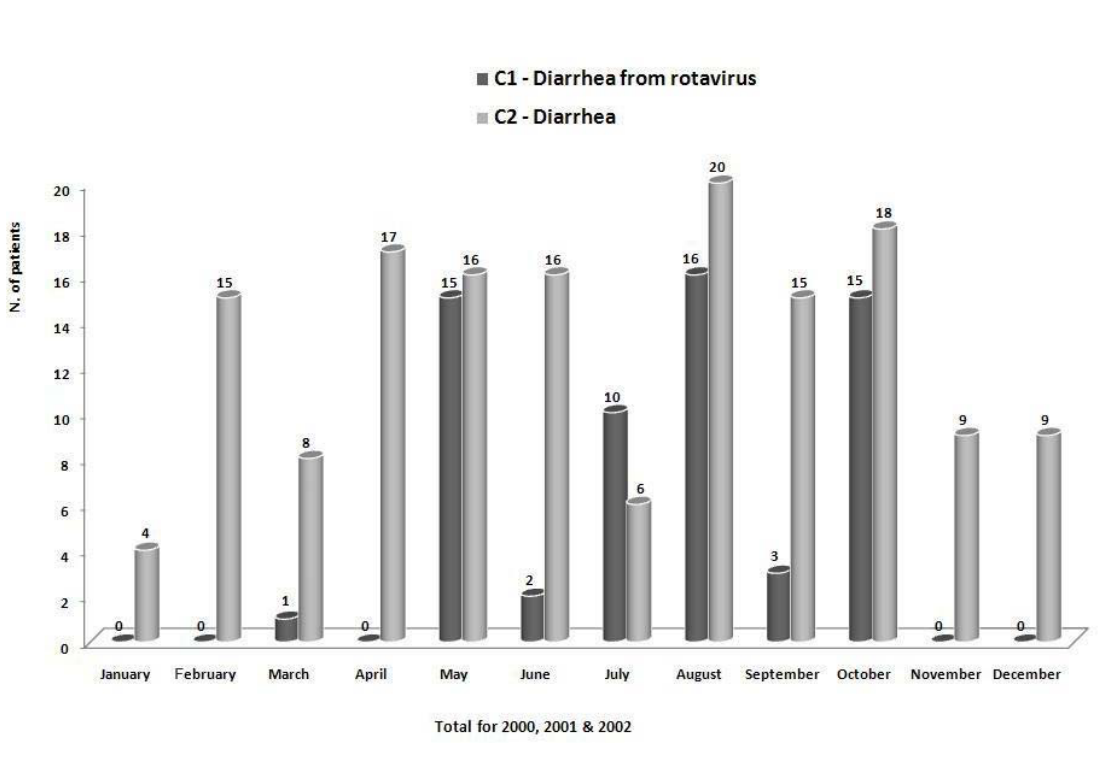
Figure 1. Distribution of 215 children with craniofacial malformations and diarrhea of groups C1 and C2 according to months, from 2000 to